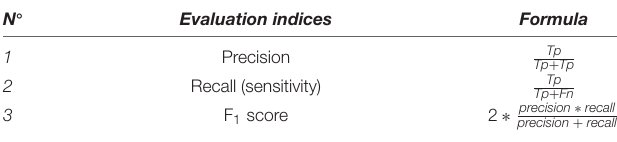
TABLE 2 | Formula of evaluation metrics used to assess ConvNet